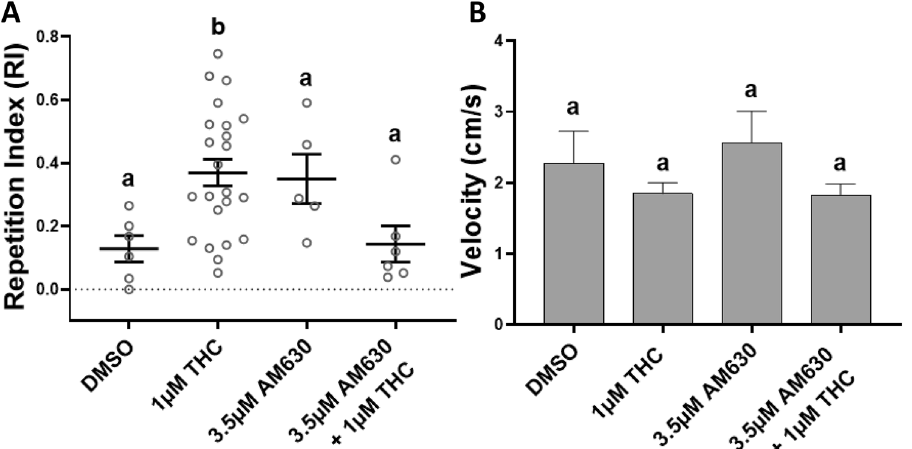
Figure 5. Co-administration of Tetrahydrocannabinol (THC) and the inverse CB 2 R agonist AM630 significantly reduced the THC-induced behavioral stereotypy in adult zebrafish. ( A ) At 3.5 μM AM630 with 1 μM THC the THC-induced Repetition Index (RI), calculated as a mean ± SEM, was not statistically different from the controls (DMSO) (ns p > 0.9999). ( B ) AM630 and THC co-administration did not affect the swimming velocity during exposure. Controls (DMSO 1%, n = 6), 1 μM THC (n = 23), 3.5 μM AM630 (n = 5) and 3.5 μM AM630 + 1 μM THC (n = 6). Values without a letter in common are statistically different to the control condition ( p < 0.05, Kruskal–Wallis and Dunn’s multiple comparisons